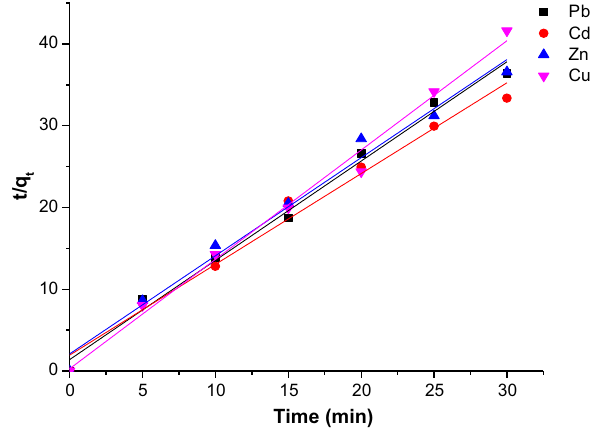
Fig. 15 Pseudo-second-order plots for Pb(II), Cd(II), Zn(II) and Cu(II) ion removal at different